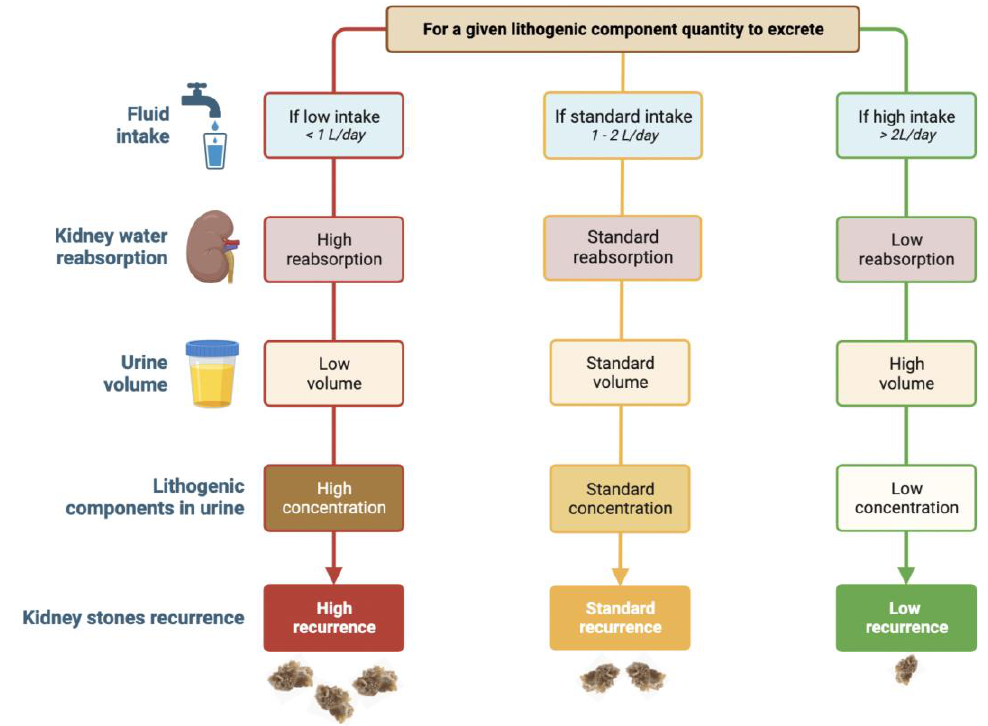
Figure 2. Relationship between fluid intake and kidney stone recurrence. For a given lithogenic component quantity to excrete, the volume of fluid intake is responsible for the amount of kidney water reabsorption and thus final urine volume, lithogenic component concentration in urine and, finally, kidney stone recurrence. With low fluid intake (left part), kidney water reabsorption is high, leading to a low volume of urine with a high concentration of lithogenic components, thus favoring kidney stone recurrence. With high fluid intake (right part), kidney water reabsorption is low, leading to a high volume of urine with low concentration of lithogenic components, preventing stone